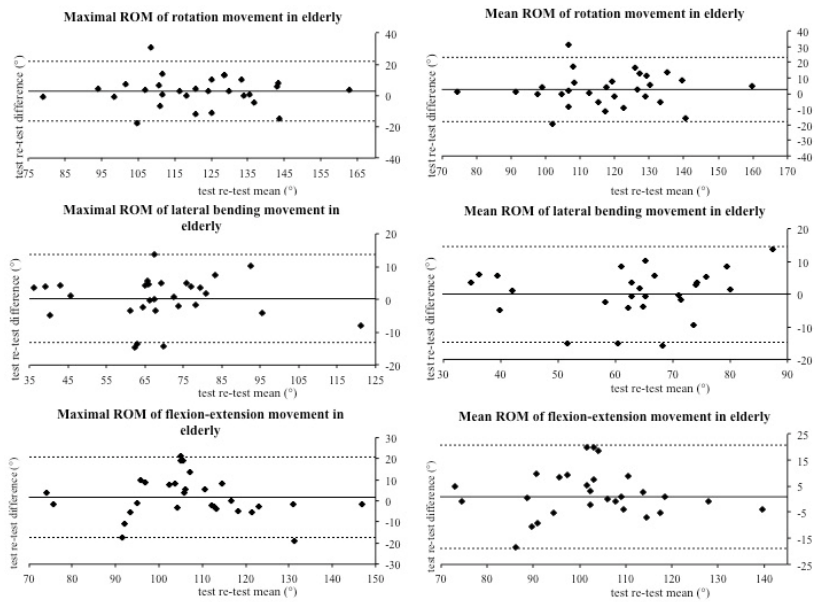
Figure 3. Bland–Altman plots of maximum and mean range of motion in elderly subjects.